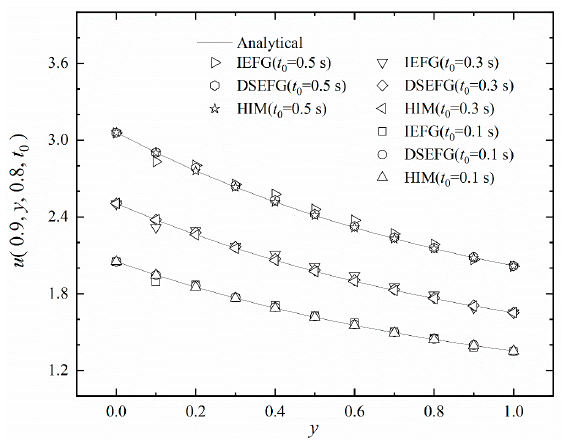
t is different. t is different. 0 0